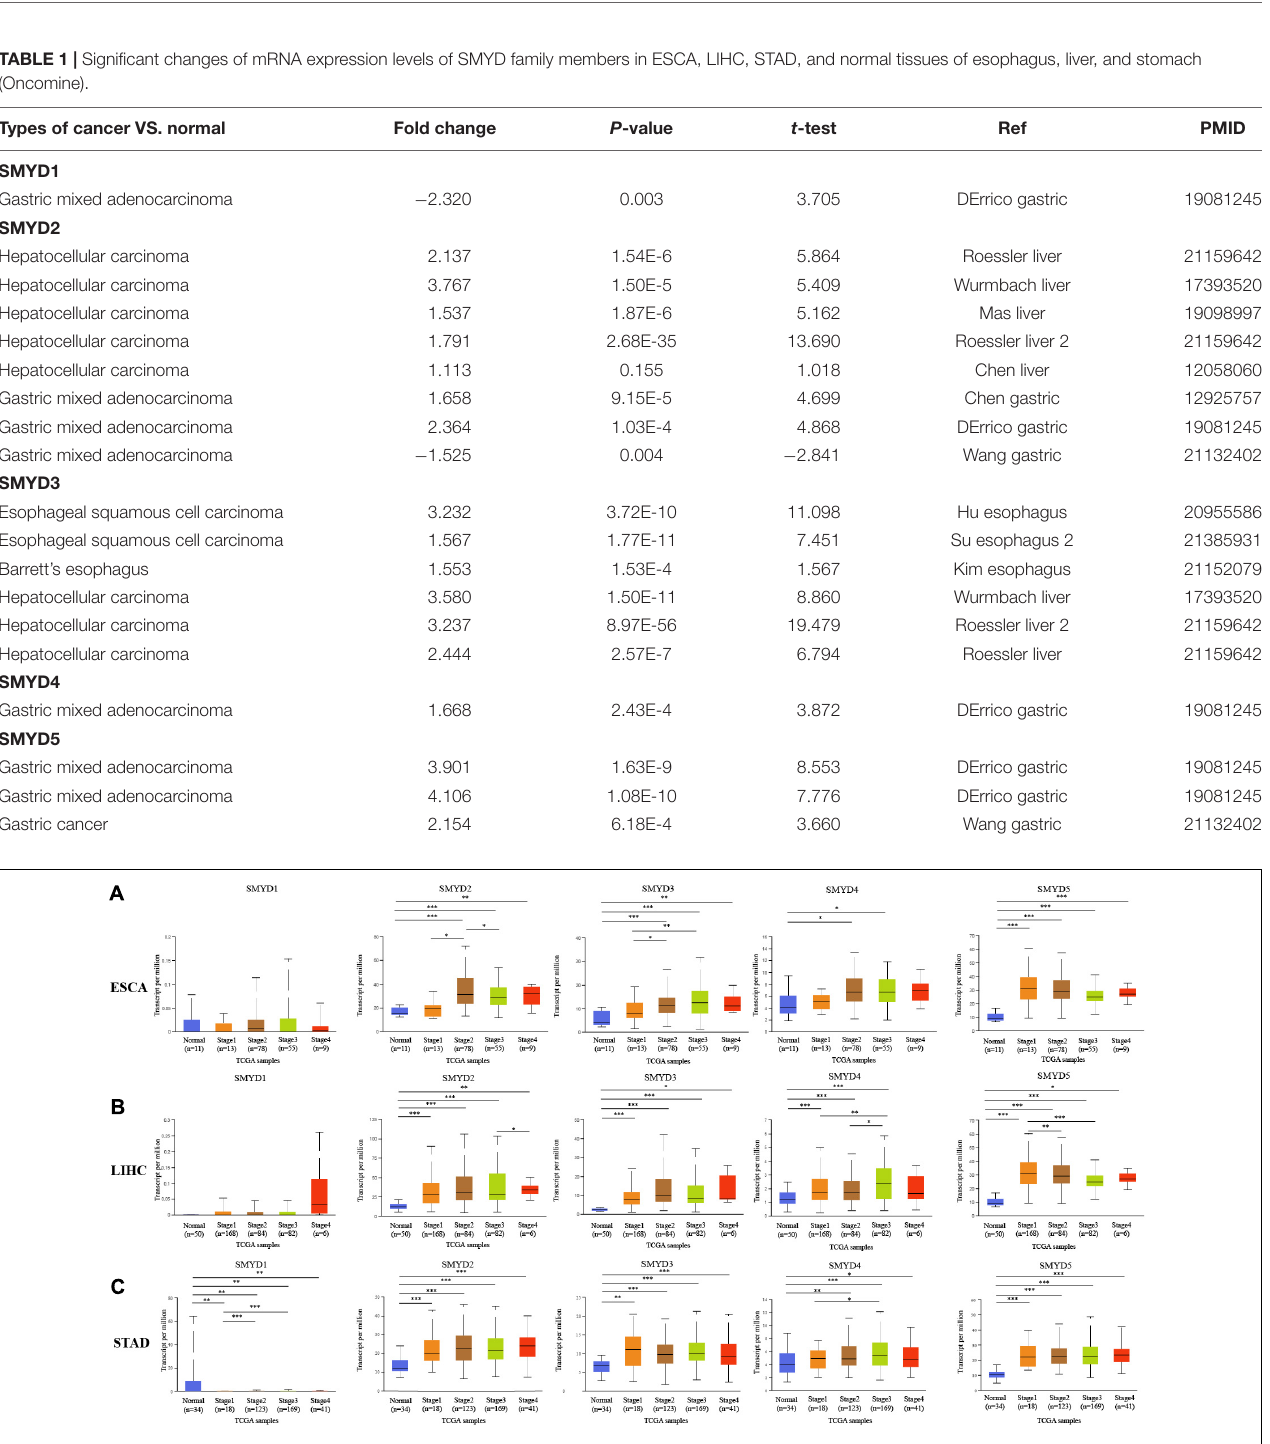
FIGURE 2 | The relationship between mRNA expression levels of SMYD family members and clinical stages in ESCA, LIHC, STAD (stage-1/2/3/4 is orange, brown, green, and red, respectively), and normal tissues of esophagus, liver, and stomach (blue) (UALCAN) (A–C) ( ∗ P < 0.05, ∗∗ P < 0.01, ∗∗∗ P <